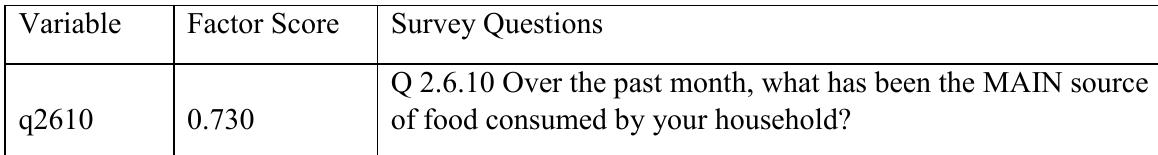
Table 1.18: Variables defining Absorptive Resilience PC9